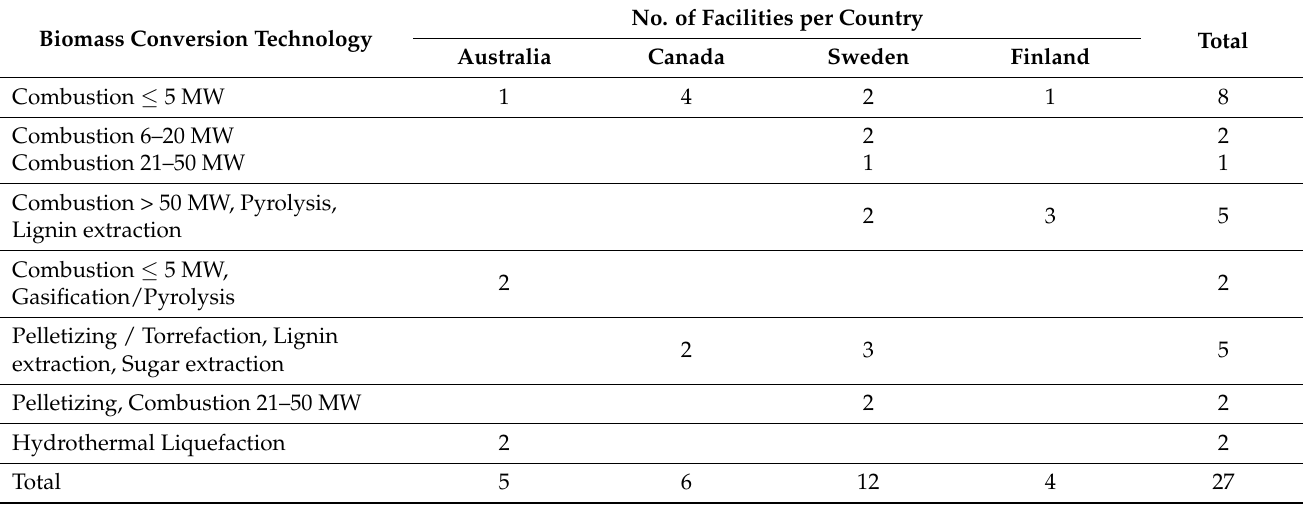
Table 2. Number of facilities by country and biomass conversion technology.